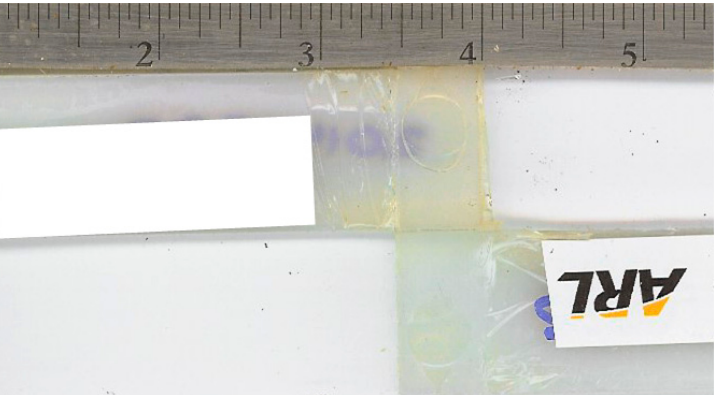
Figure 13. A picture showing the post-testing separated joints for the lap shears bonded with EPON 825/JEFFAMINE D-230.